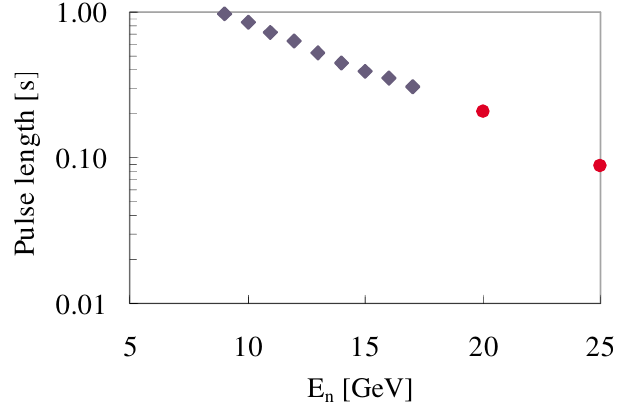
FIG. 3. (Color) rf pulse length versus final beam energy E Nominal range (diamonds), extended range (solid circles).